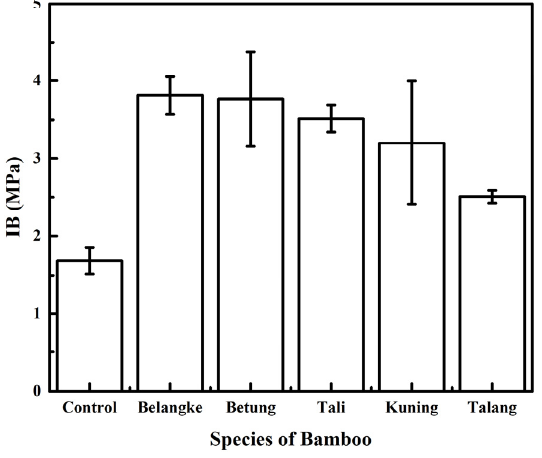
Figure 5. Internal bonding (IB) of